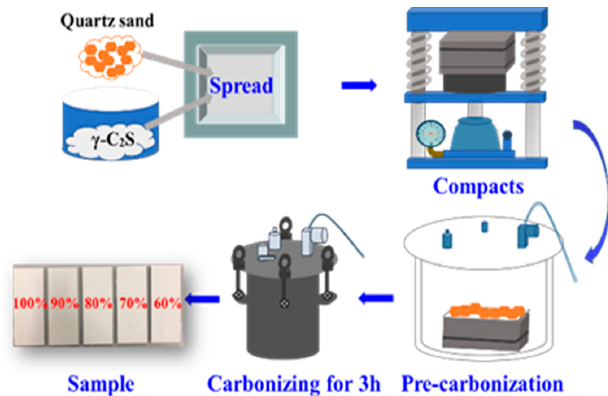
Figure 9. Preparation schematic diagram of photocatalytic γ -C 2 S carbonated matrix.